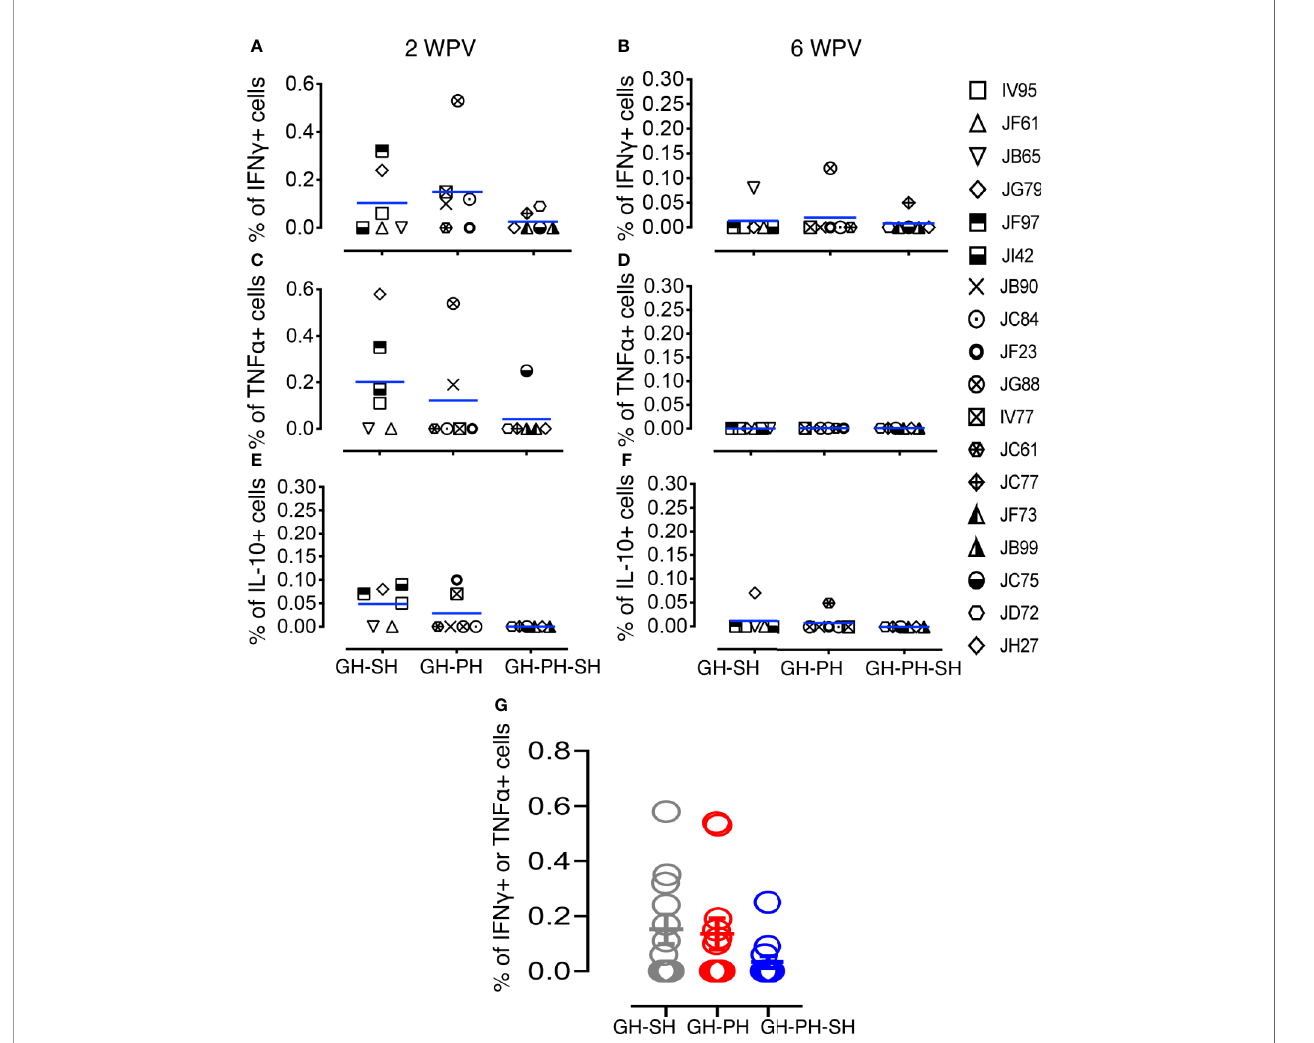
FIGURE 8 | Measles and canine distemper speci fi c CD8 T cell responses in canine distemper and measles vaccinated macaques. Intracellular IFN g responses (A, B) , TNF a responses (C, D) and IL-10 responses (E, F) were measured against lysed Canine Distemper measles vaccine (CDMV) at 2 weeks and 6 weeks post-vaccination (WPV) in three different housing groups of macaques. CDMV speci fi c IFN g or TNF a responses in CD8+ T cells were shown for all three groups at 2 WPV with mean ± standard error (G) . Blue lines in (A – F) graphs represent group means for each group. Criteria for a positive cytokine response was a two-fold increase in frequency for measles and canine distemper antigen and cytokine above the medium control culture. All values were subtracted from medium control before